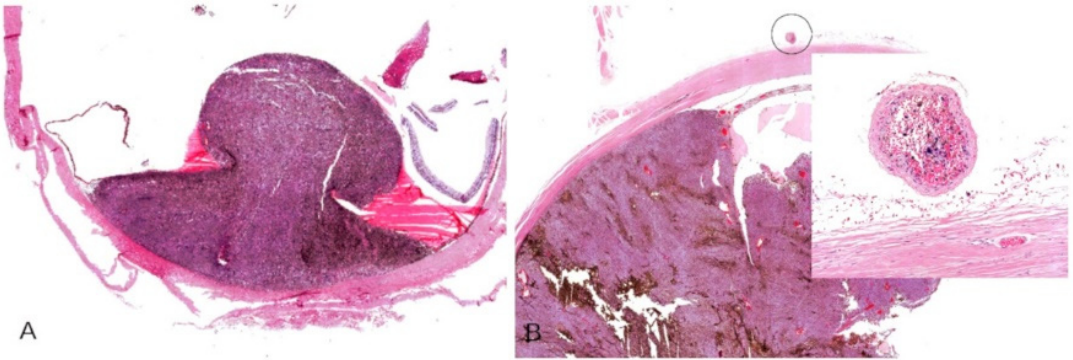
Figure 5. ( A ) Uveal melanoma with mushroom-shape. ( B ) Vascular invasion, malignant cells in a Figure 5. ( A ) H&E image (panoramic view): Uveal melanoma with mushroom-shape. ( B ) H&E image ( × 40): Vascular vorticose vein. invasion, malignant cells in a vorticose vein ( × 400).